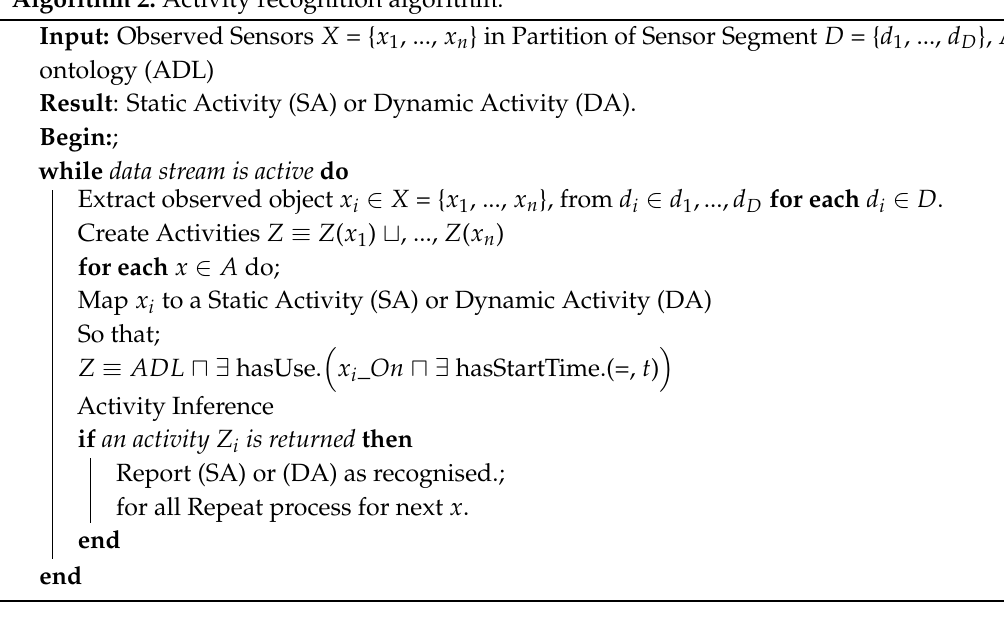
Algorithm 2: Activity recognition algorithm.